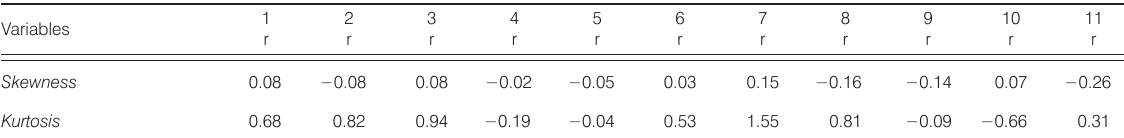
Table 2. Descriptive statistics, Cronbach’s a , and correlations for major study